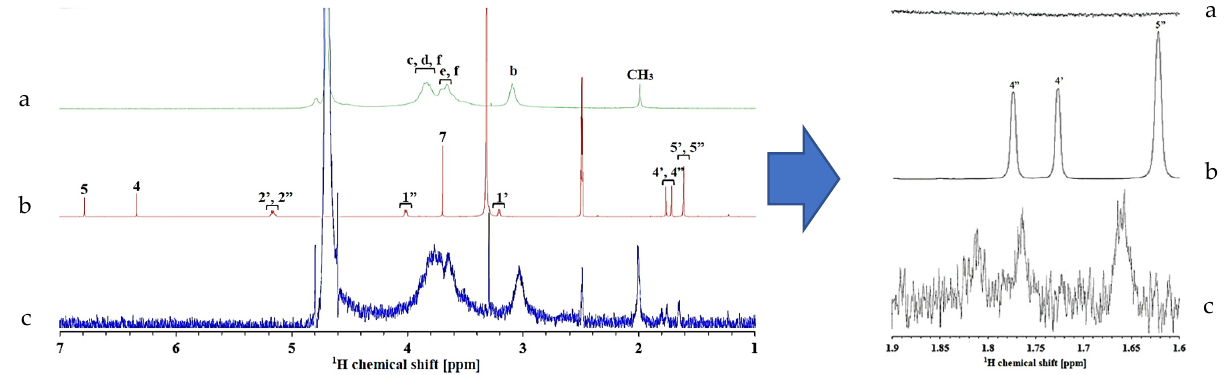
8 of 13 Figure 7. FT − IR spectrum of each sample in the range of 1520 − 1760 cm − 1 . 3.4. NMR Analysis To confirm the molecular state of AM and the interaction of AM–WSC in the super- saturated solution, 1 H NMR was also performed. The molecular-level characterization of supersaturated solutions is necessary to exhibit the mechanism of the inhibition of drug crystal nucleation because the formation of crystal nuclei in the drug-supersaturated so- lutions occurs on a tiny scale. NMR is a valuable technique for the characterization of the molecular states of drugs and additives in a solution. The chemical shifts and peak widths of the drug in the NMR spectra reflect their chemical environment and molecular mobil- ity, which were used to evaluate the intermolecular interactions between drugs and pol- ymers. The analysis of NMR was performed for the proton ( 1 H-NMR), and the 1 H NMR spectra of each sample are shown in Figure 8. The peak assignments of AM and WSC were assigned as described in the previous reports [31,32]. The AM peaks were shifted upfield by the addition of WSC in the supersaturated solutions of AM, specifically for H4 and H5 peaks. The AM peaks were significantly broadened, indicating mobility suppression of AM in the WSC solution. Thus, AM mobility was suppressed in the presence of WSC.